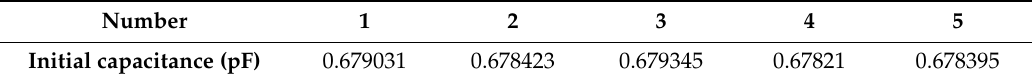
Figure 13. The static experiment test bench. Table 4. Initial capacitance of five